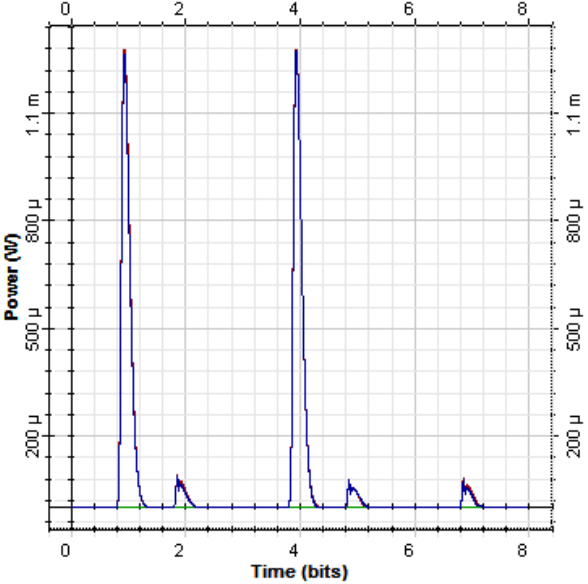
Figure 5. Time domain output for BPF2.